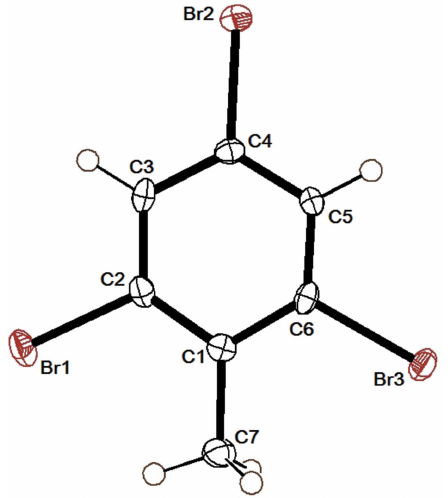
Figure 2 The molecular structure of TBTwith the atom labelling and displacement ellipsoids drawn at the 50% probability level.